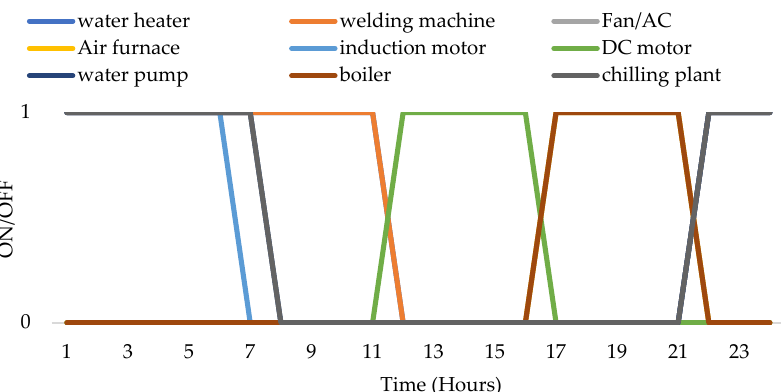
Figure 9. ON/OFF period of individual devices for commercial area.